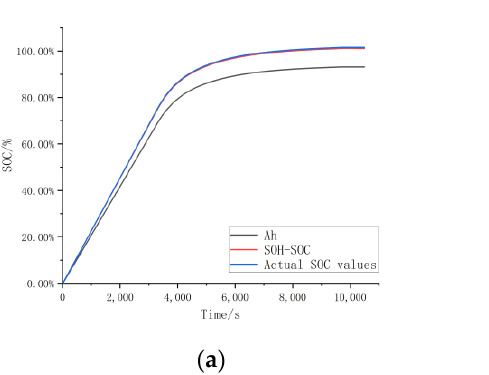
Figure 14. SOC change curve for the 5th use cycle of the No. 5 battery. ( a ) Charging process SOC change curve. ( b ) Discharging process SOC change curve.